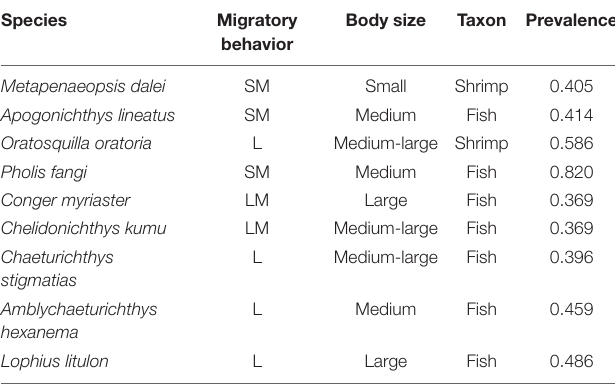
TABLE 1 | Summary of biological traits of the nine demersal species being